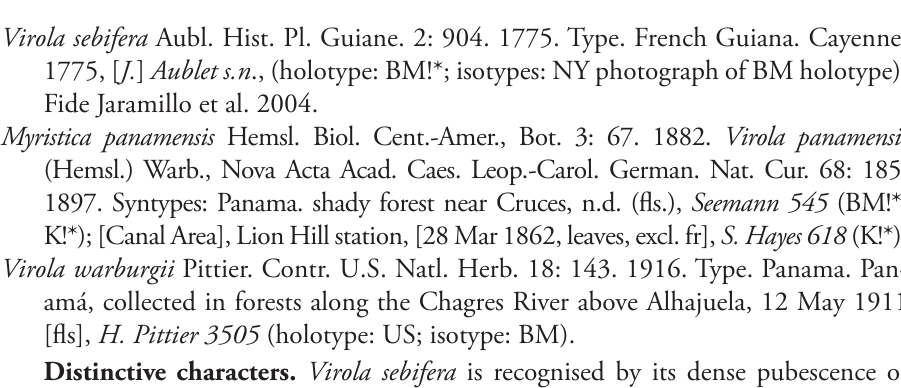
Virola sebifera Aubl. Hist. Pl. Guiane. 2: 904. 1775. Type. French Guiana. Cayenne, 1775, [ J. ] Aublet s.n ., (holotype: BM!*; isotypes: NY photograph of BM holotype).